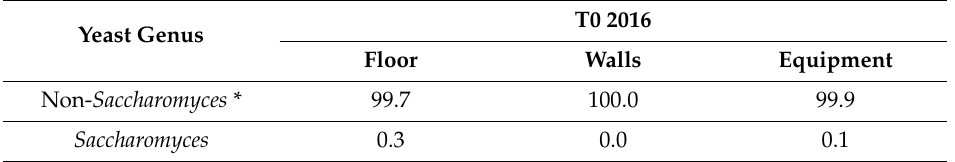
Table 2. Percentages of non- Saccharomyces and Saccharomyces genera identified on wine-related environments (WREs) before the arrival of the first harvest by Illumina